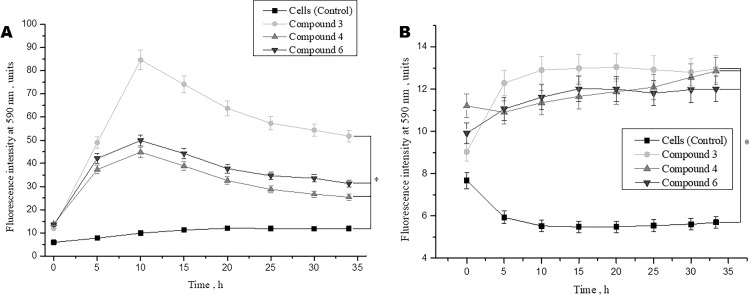
Effect of DNICs on the cell viability of human lung embryonic fibroblasts (cell line HLEF-104) (A) and rat cardiomyocytes (cell line H9c2) (B) for 35 h. DNICs (2 × 10-4 M) were added to cells, then cell viability was tested in fibroblasts and rat cardiomyocytes by AlamarBlue® Cell Viability Assay. *P ≤ 0.05 vs. control group. The values presented are the means ± SD of four independent experiments, n = 4.